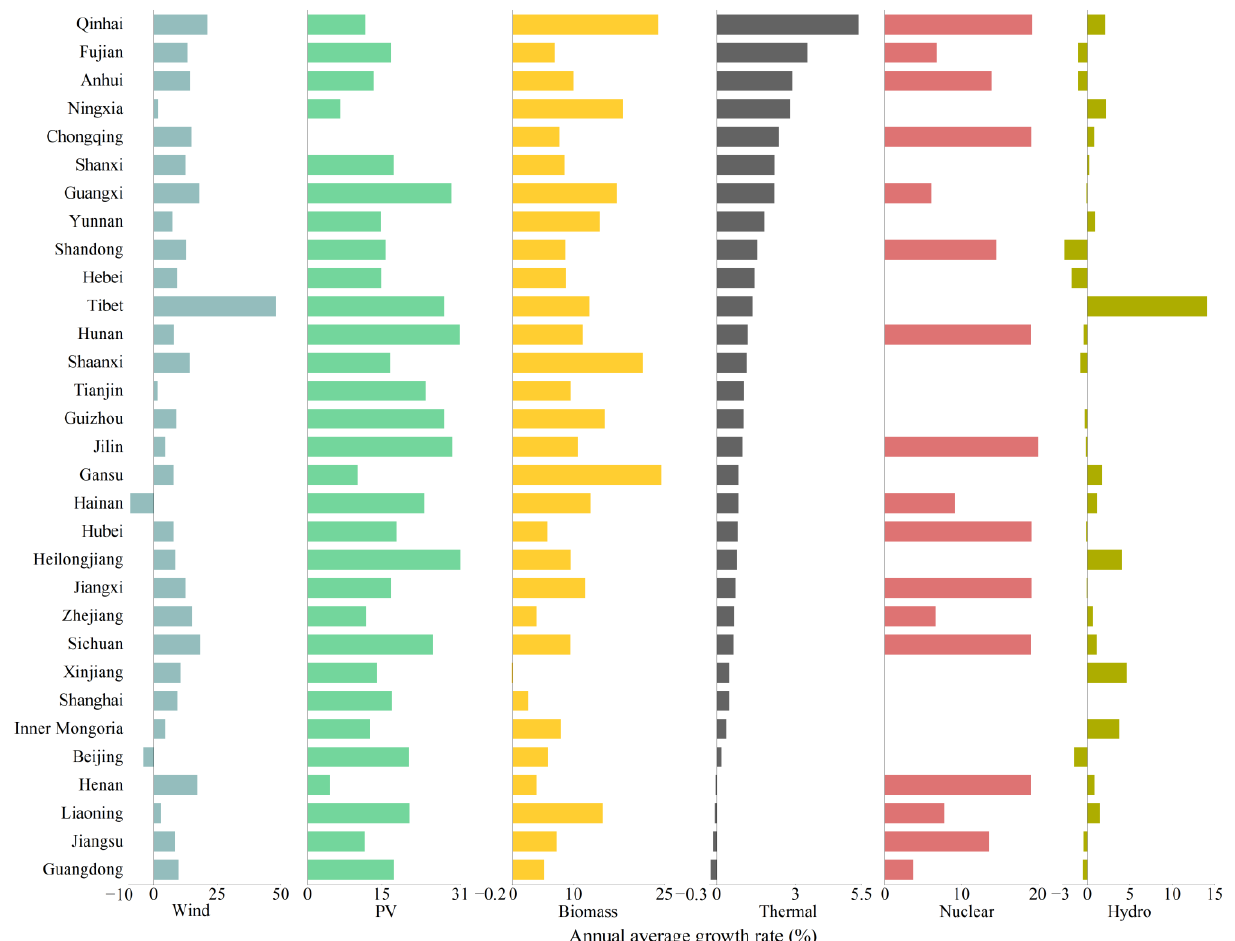
Figure 6. Annual Average Power Generation Growth Rate from 2016 to 2040.